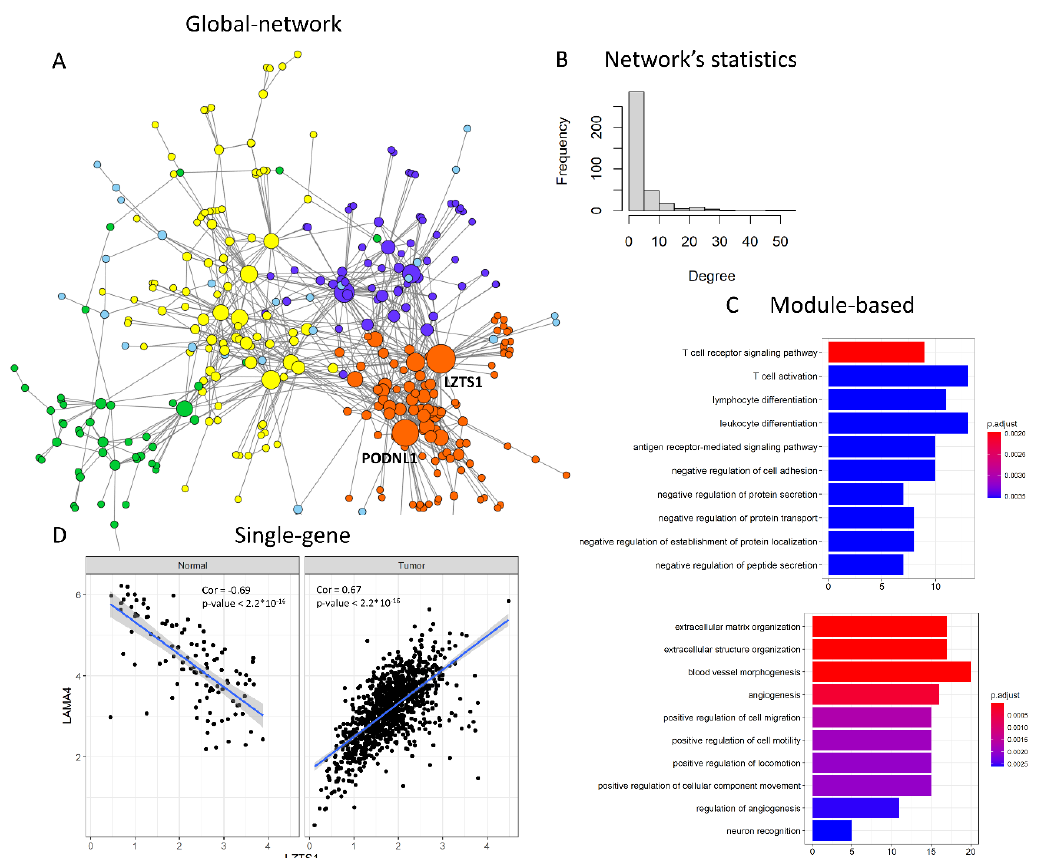
Figure 4. Example of di ff erential co-expression analysis comparing TCGA normal tissue and breast tumour transcriptional data. ( A ) In a “global network” approach, the whole di ff erentially co-expressed network is obtained. Here, only the top significantly di ff erentially co-expressed genes are shown for simplicity (adjusted p -value < 10 − 40 ). Each node is a gene, colour indicates the cluster and size indicates the number of connections of that gene. The two nodes with the highest degree of di ff erential connections are indicated (LZTS1 and PODNL1); ( B ) The di ff erentially co-expressed network can be analysed as a whole, studying its topological properties, such as degree distribution; ( C ) In the global network, clusters (modules) can be identified and studied through functional enrichment, in a “module-based” approach. The top significantly enriched Gene Ontology (GO) categories for the two largest modules are shown in the two boxes, with bars indicating the number of genes belonging to each GO category and colour indicating the adjusted p -value; ( D ) Node and edge prioritisations allow for selecting specific genes or gene pairs with a particularly strong change in connectivity between the compared conditions: LZTS1 and LAMA4 are significantly negatively correlated in normal breast and switch to a positive correlation in breast